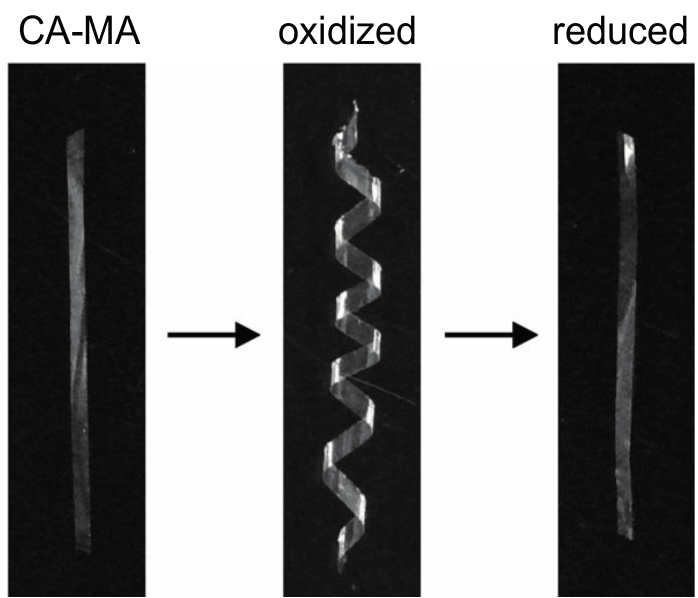
Figure 10. Shape memory–recovery behavior of a ca . 6 µm-thick CA-MA film. Reprinted with permission from ref. [34]. Copyright 2007 American Chemical